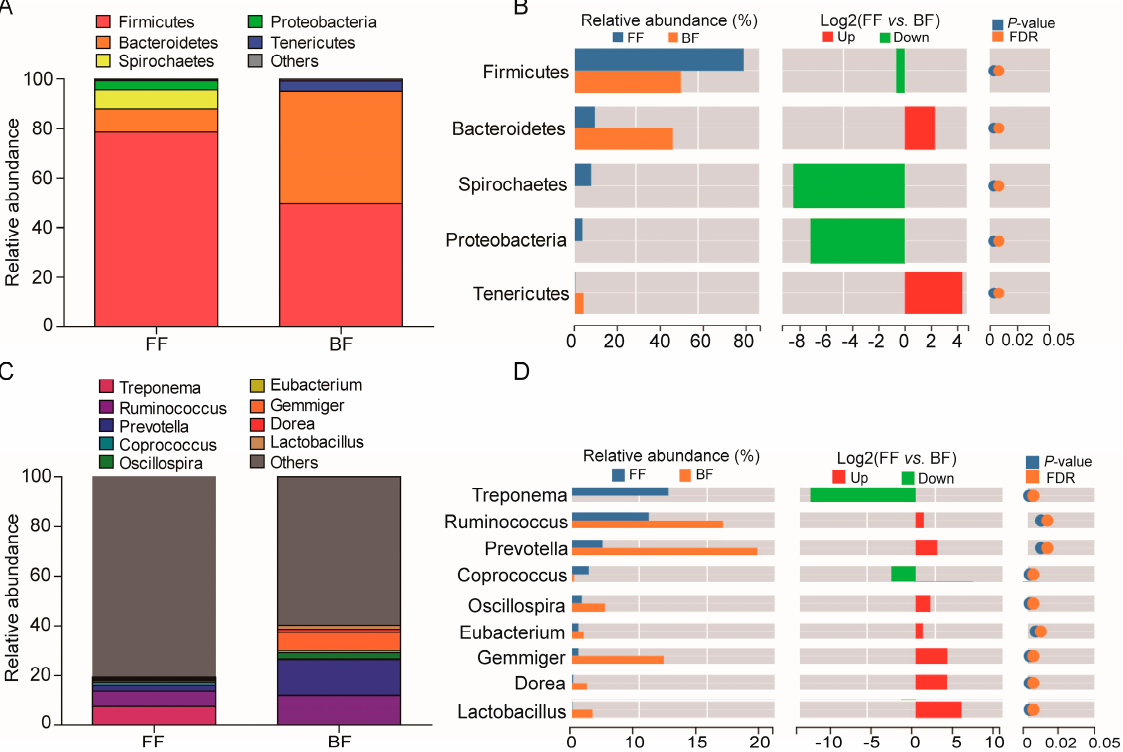
Figure 3. Microbial community composition: ( A ) Composition at the phyla level; ( B ) Relative abundance at the phyla level; ( C ) Composition at the genera level; ( D ) Relative abundance at the genus level.